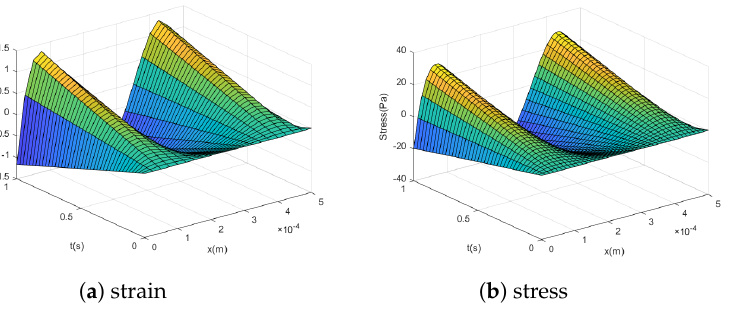
Figure 6. Stress and strain in the viscoelastic micro-beam under f ( x , t ) = 100 ( x − 2 ) cost